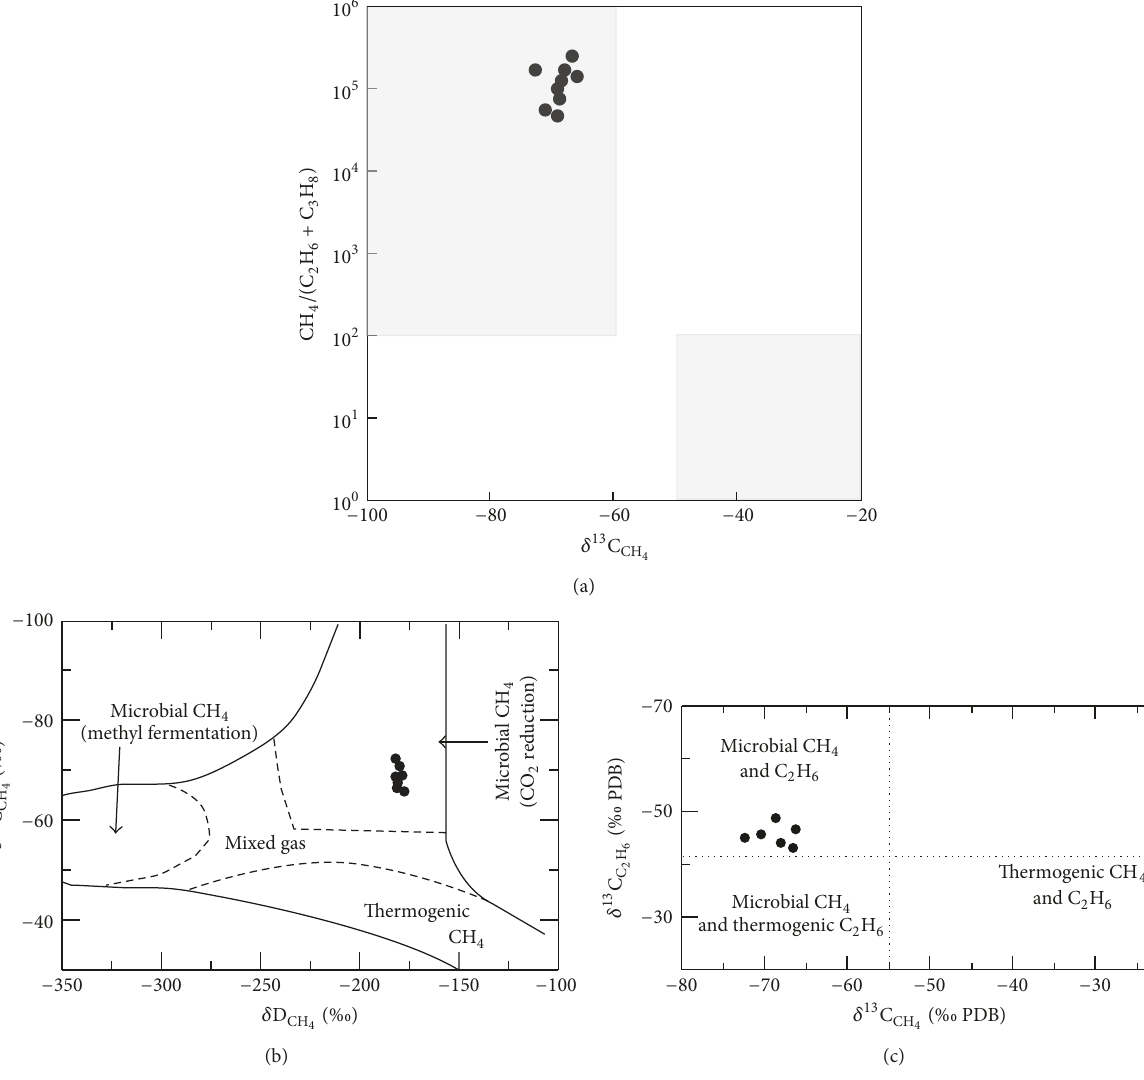
Figure 4: Diagrams for the study venting gases of the Aquitaine Shelf of (a) 𝛿 13 C CH composition ratio (modified after Bernard et al., 1978); (b) 𝛿 13 D CH 𝛿 13 C 𝛿 13 C CH 4 versus CH 4 (modified after Bernard et al.,